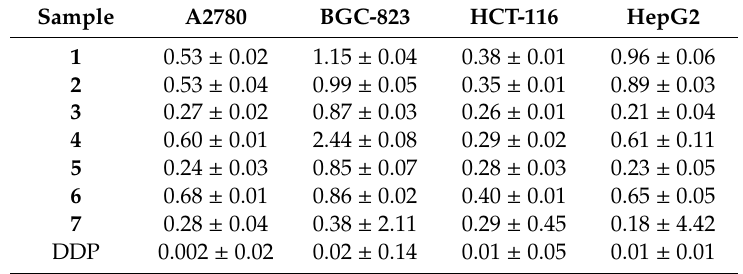
Table 2. Cytotoxic activities (IC 50 , mM) of all tested compounds on four human cancer cell lines.